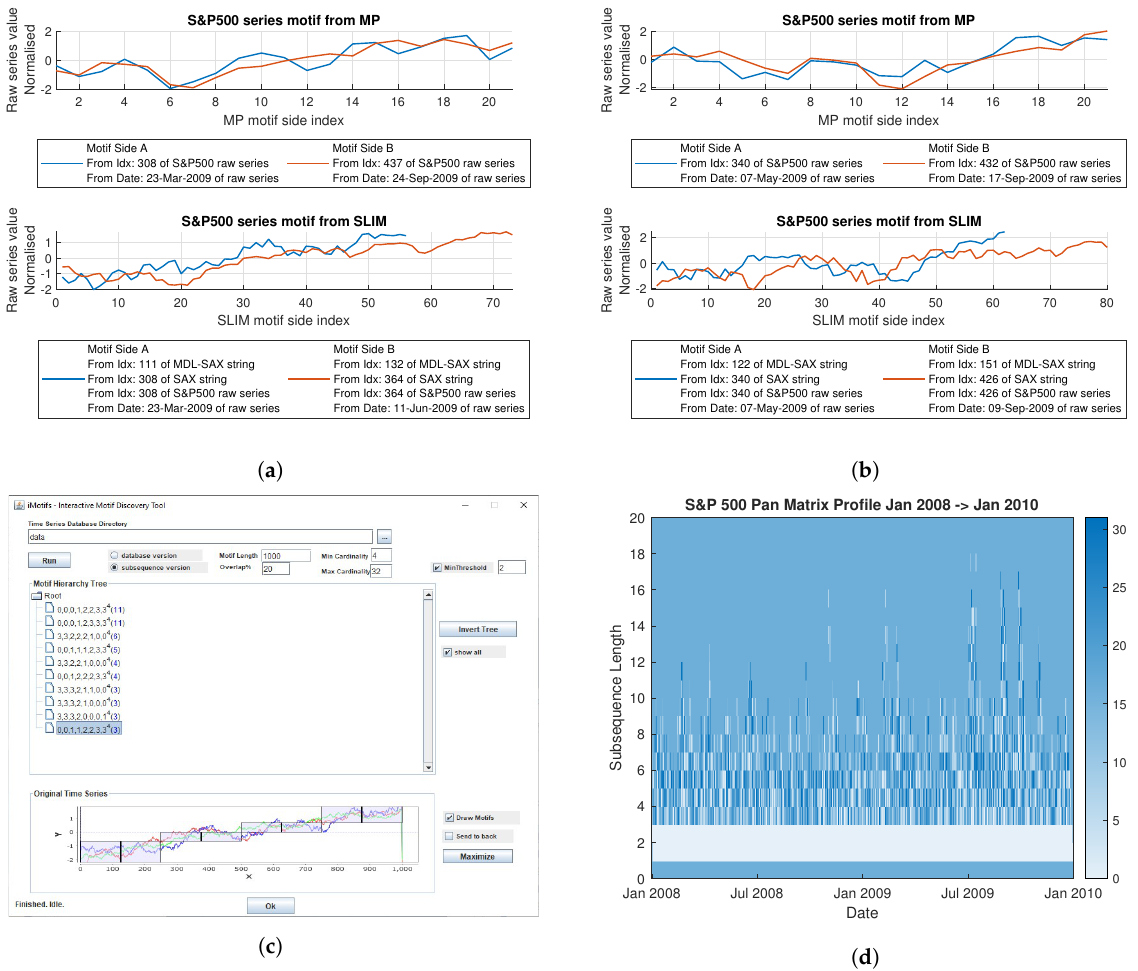
Figure 10. Comparison of motifs obtained from MP and SLIM . ( a ) SLIM vs. MP from Figure 9c. ( b ) SLIM vs. MP from Figure 9d. ( c ) MrMotif [16,17] front end. ( d ) Pan Matrix Profile ( PMP ) heatmap created by the SKIMP [26]